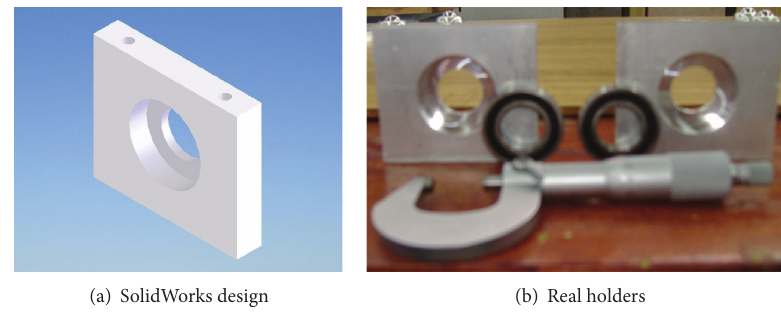
Figure 7: Holding bars design.